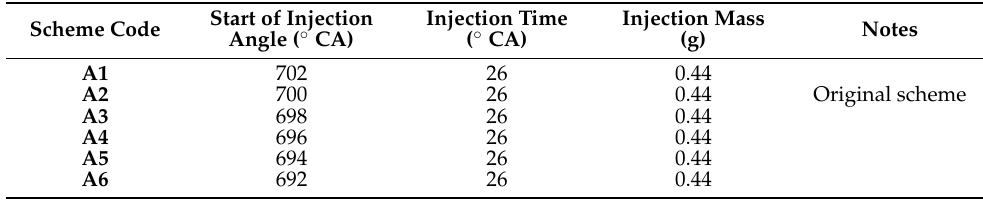
Table 6. Scheme of the start of injection angle.